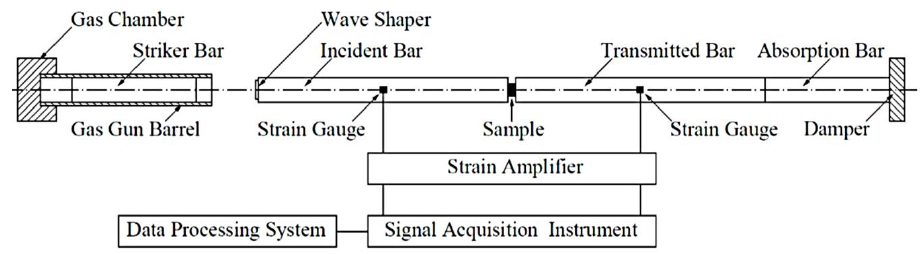
Figure 7. Schematic diagram of the SHPB test system.